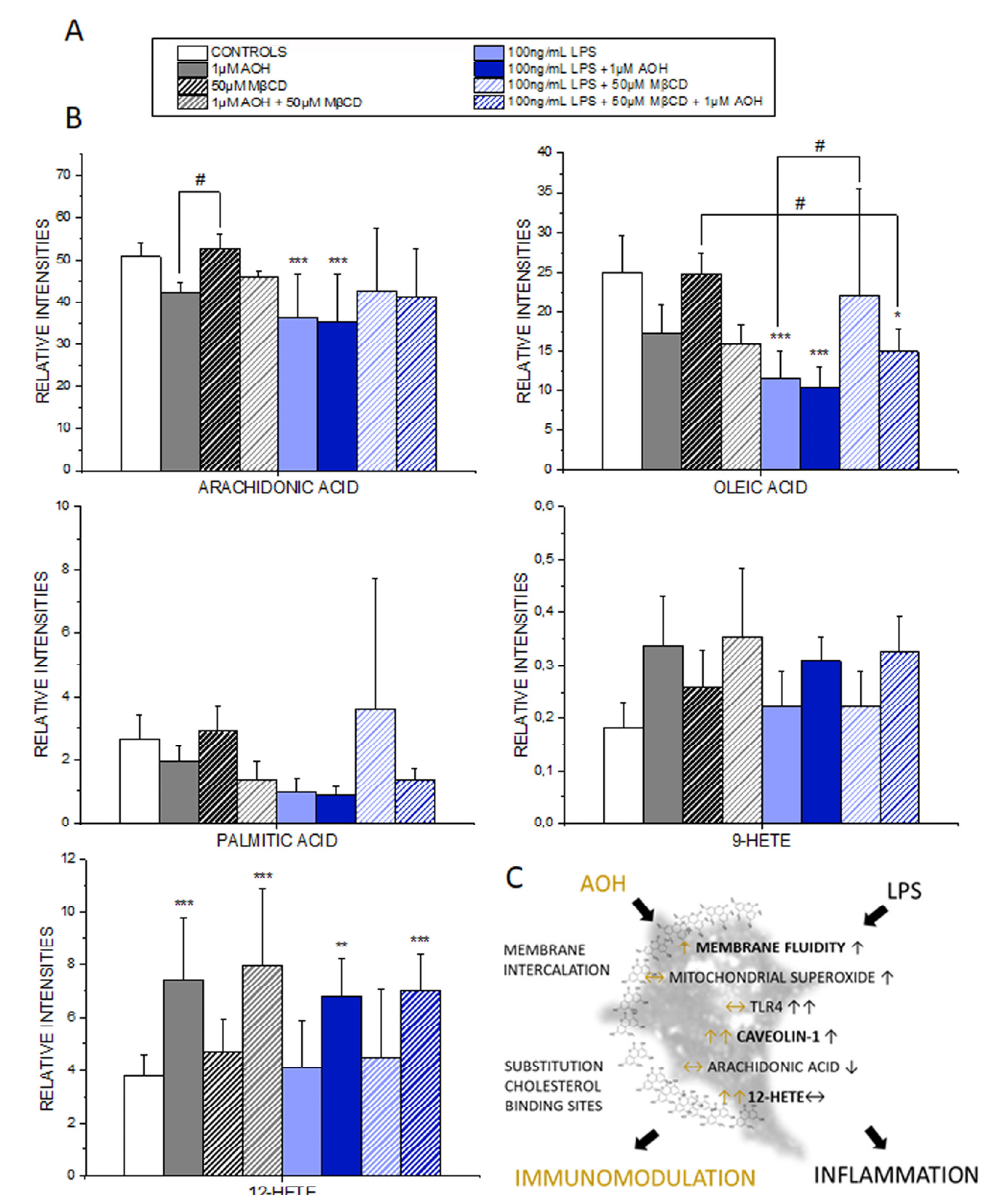
Figure 7. Influence on arachidonic, oleic and pamititc acid and on 9-and 12-HETE in the secretome of THP-1 macrophages (3 h incubation). ( A ) Figure color legend. ( B ) Data are depicting results obtained from 3 independent cell preparations. * ( p < 0.05), ** ( p < 0.01), *** ( p < 0.001) indicates significant di ff erences in comparison to controls and # ( p < 0.05) indicates significant di ff erences among the treatments (ANOVA for multiple comparisons). ( C ) Schematic representation of the mechanism of immunomodulatory action of